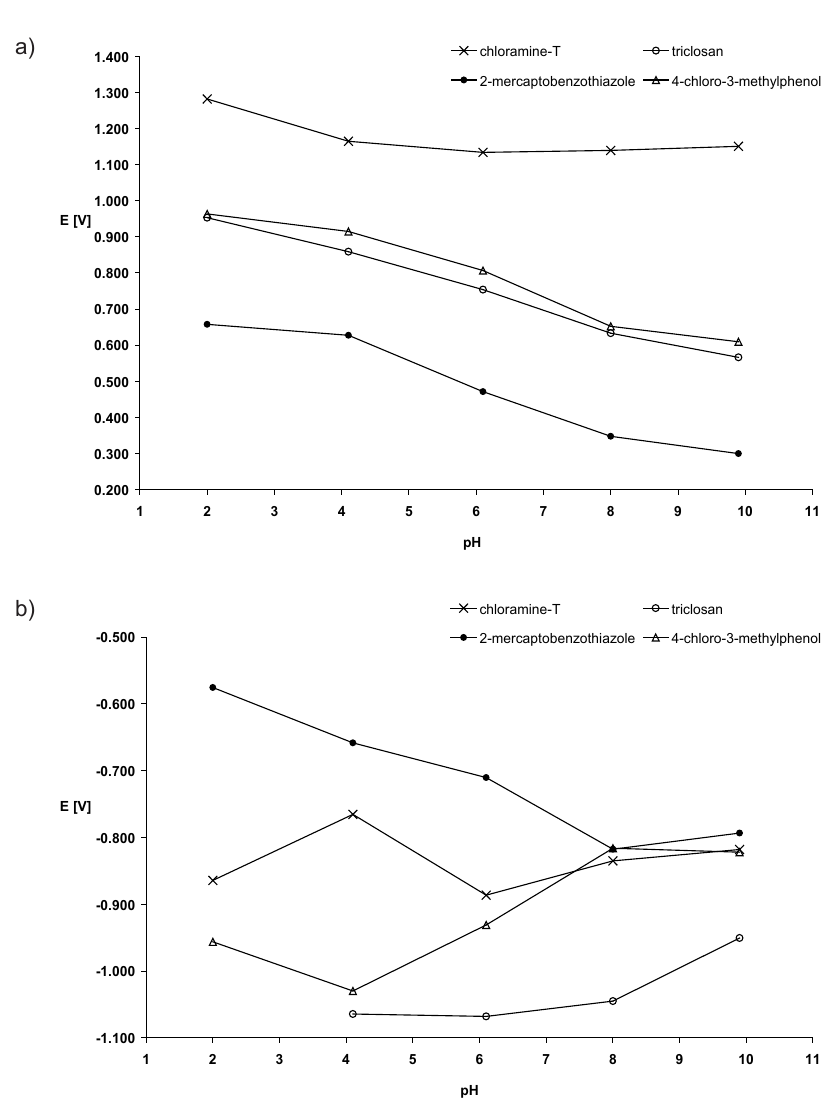
Figure 2. The plot of oxidation (a) and reduction (b) potentials versus pH. Supporting electrolyte: Britton-Robinson buffers. together in real samples. Triclosan is mainly used as an Table 1. ingredient in cosmetics, while 4-chloro-3-methylphenol is a component of disinfectant liquids. Compound Oxidation potential Calibration studies were performed by the standard addition method in Britton-Robinson buffer at pH 9.9 using differential pulse voltammetry in the potential range from 0 to 1.2 V at a scan rate 50 mV s -1 . Each measurement was repeated three times with fresh the solution and buffer of pH 9.9 was used as a supporting electrolyte. working and counter electrodes were cleaned each Voltammograms were recorded for pairs of compounds time. Calibration graphs of studied disinfectants are which can occur simultaneously in cosmetics, household described by equation y = bx + a, where “b” is the products or disinfectant lotions. Results are shown in slope, “a” is the intercept, “x” is the concentration of Fig. 3. Triclosan and 4-chloro-3-methylphenol have compound in µM and “y” is the peak current in ampere. similar results for the oxidation potentials They cannot be The calibration graph of triclosan, with equation determined simultaneously, and they also do not occur